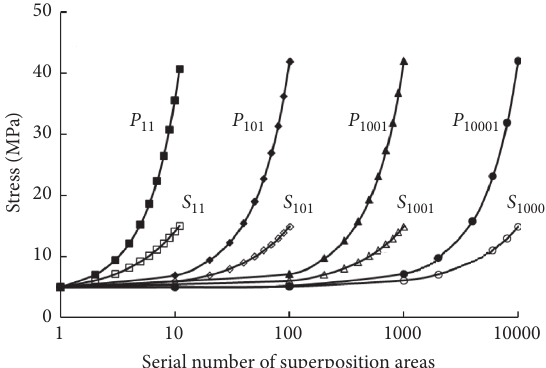
Figure 10: Stress distribution in superposition areas.